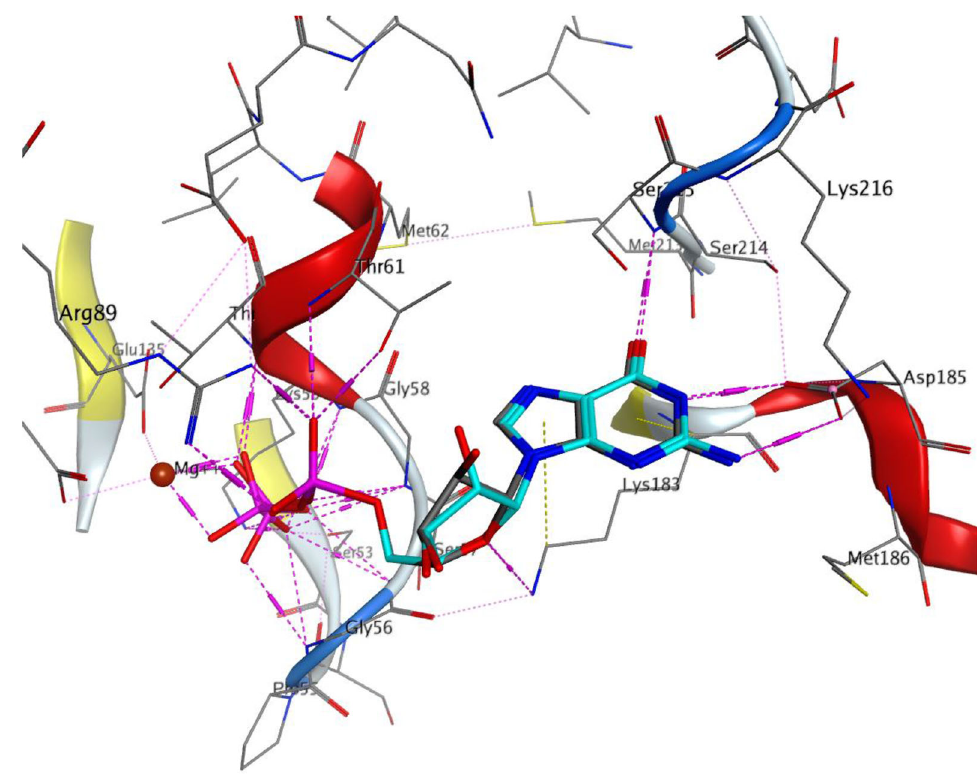
Fig. 2 Re-docked pose of the co-crystallized small molecule. The docked pose in light blue while the X-ray structure is shown in cyan. H-bonds interactions are of the small molecules are shown as broken